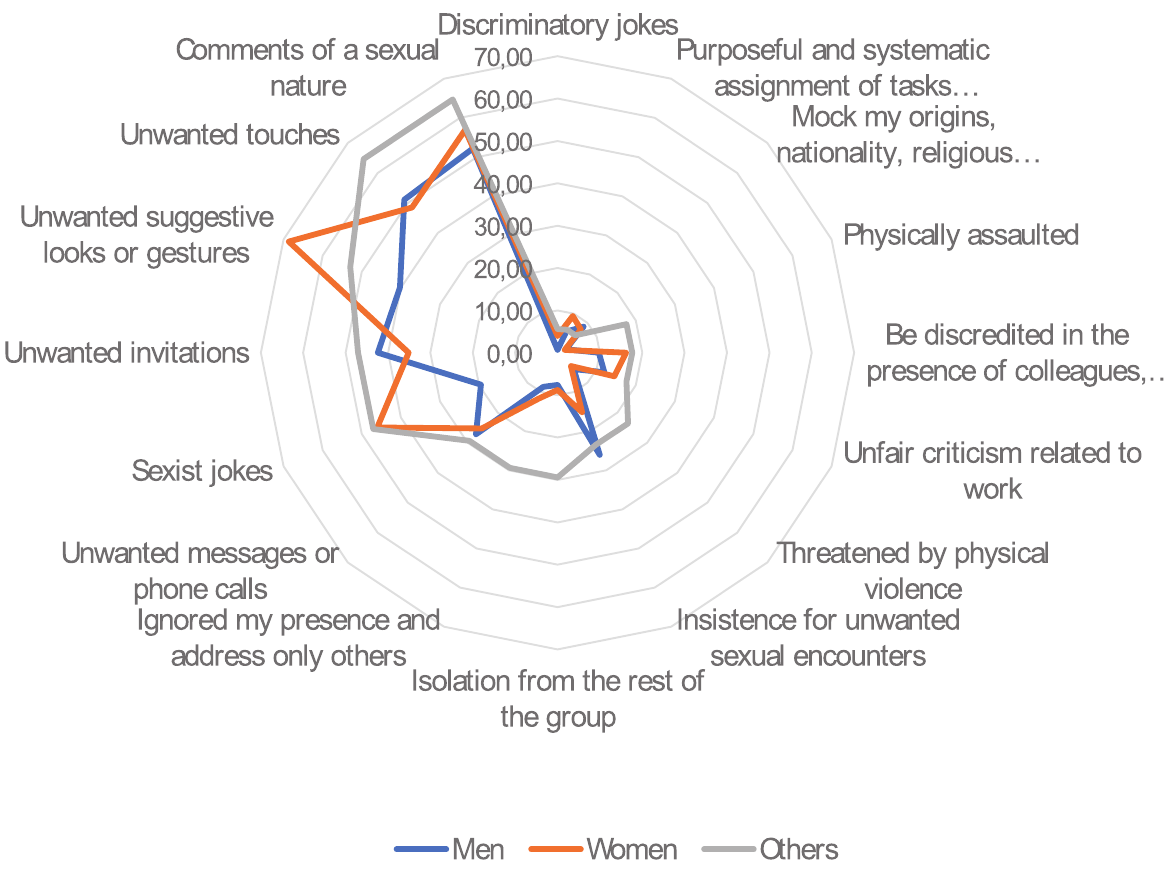
Figure 7. Percentage of forms of sexual harassment that students, professors, and staff claim to have suffered separated by gender. Full text of the summarized items: ”Purposeful and systematic assignment of tasks inferior or superior to your competences”, ”Mock my origins, nationality, religious beliefs, or political beliefs”, and ”Be discredited in the presence of colleagues, superiors, or